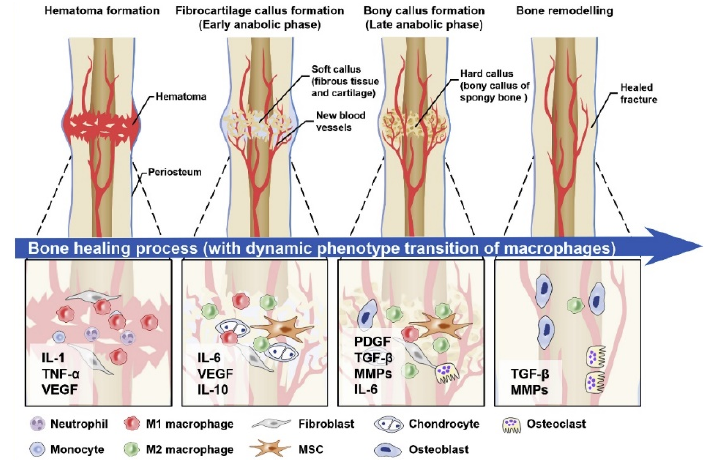
Figure 2. A graphical view of the direct bone healing process.